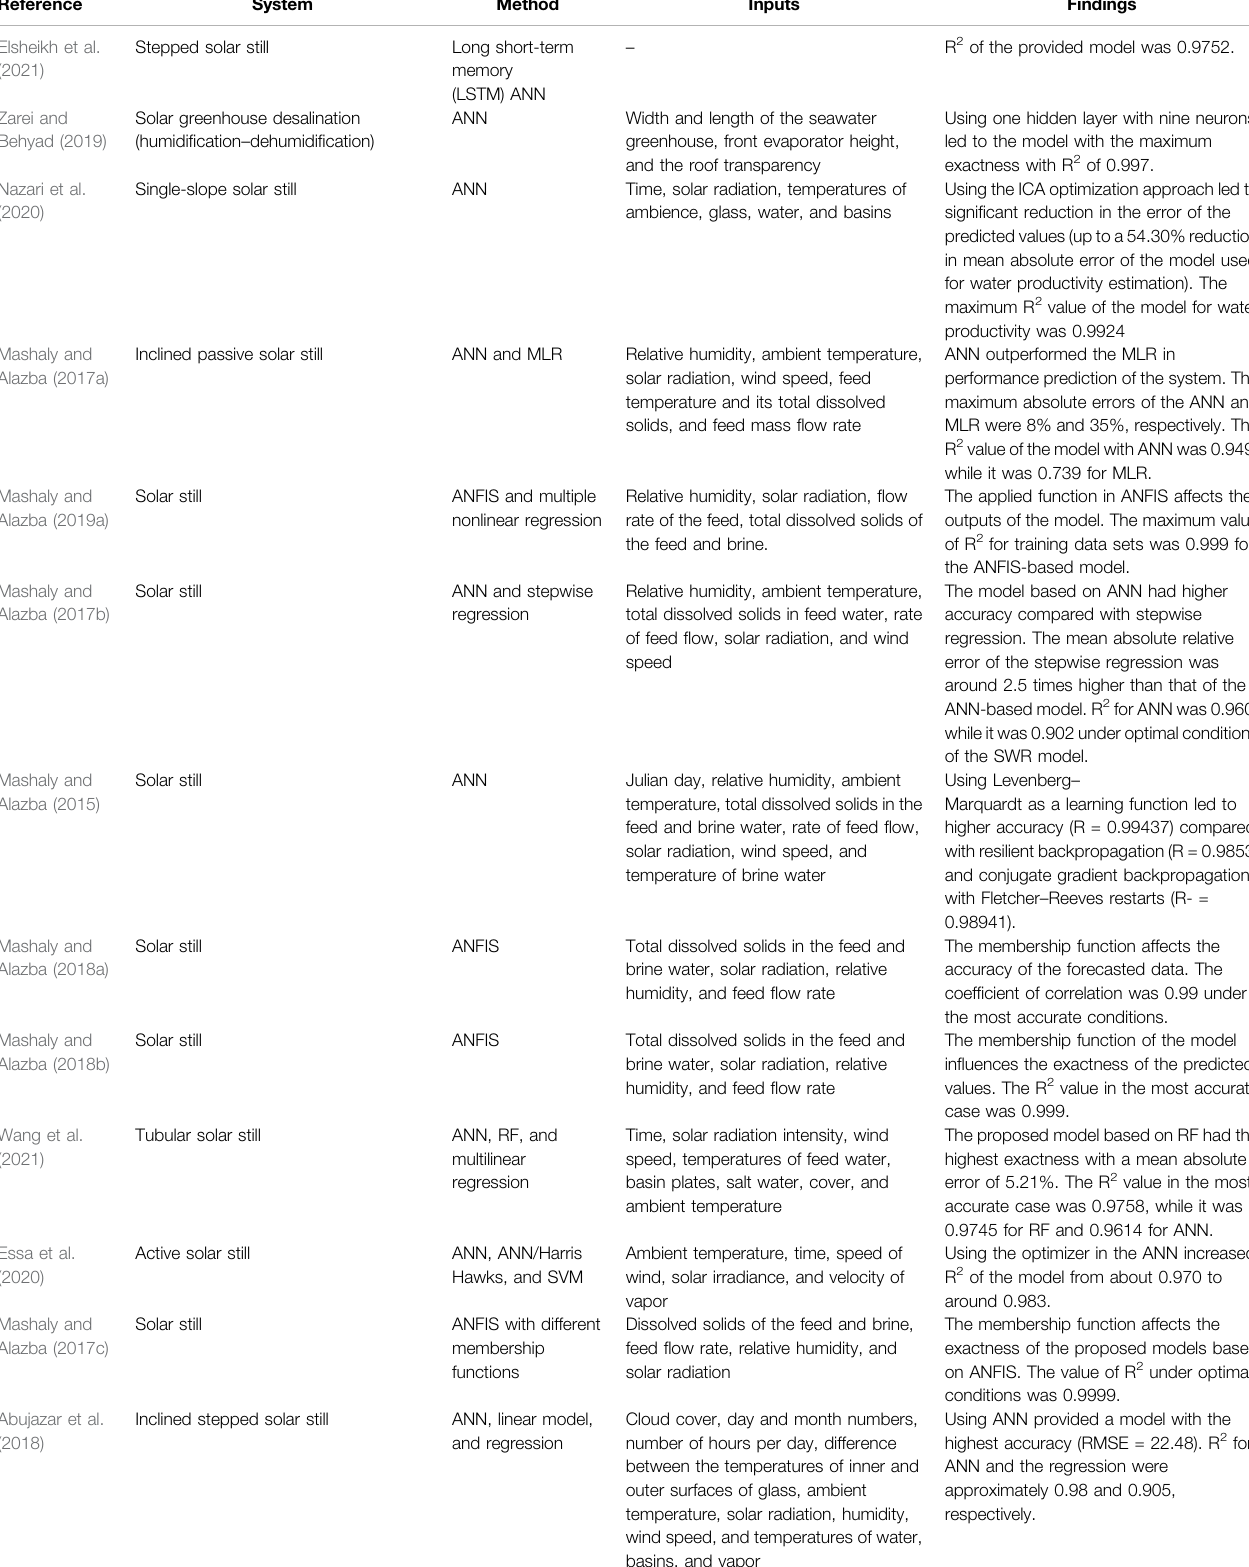
TABLE 1 | Important fi ndings of the studies on applications of data-driven methods in solar desalination systems. Reference